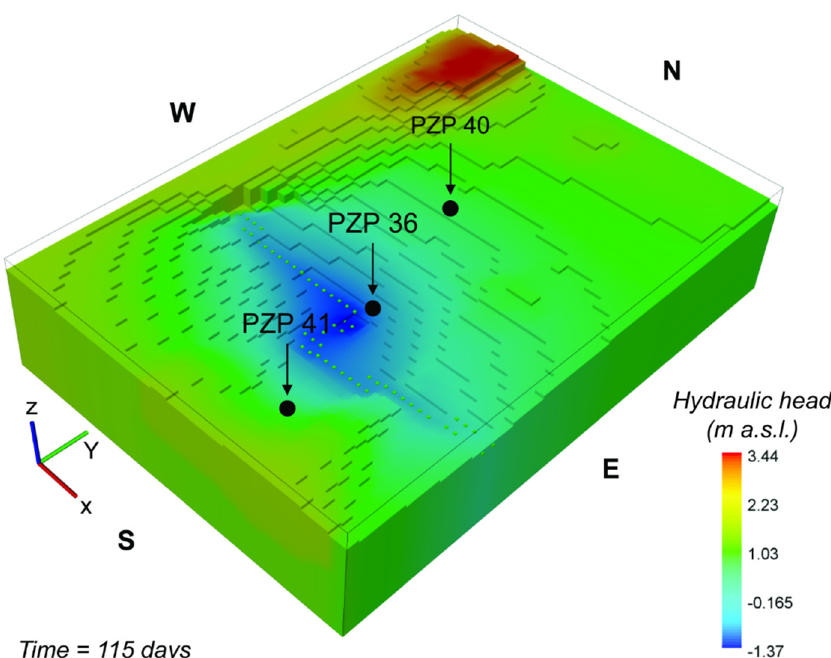
Figure 6. Simulated hydraulic head distribution within the WAA. The shown result refers to the end of the transient simulation after 115 days. The central zone is characterized by a depressed hy- draulic head level as effect of the mechanical drainage system (green dotted